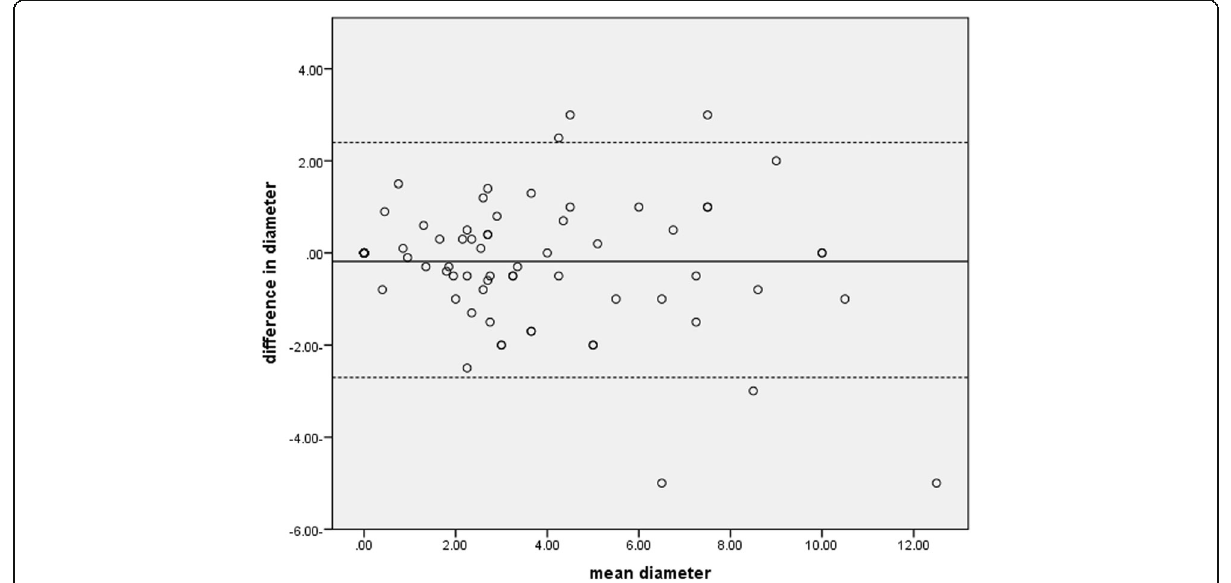
Fig. 9 Bland-Altman plots for comparison of maximum tumor diameter measurement by CESM and